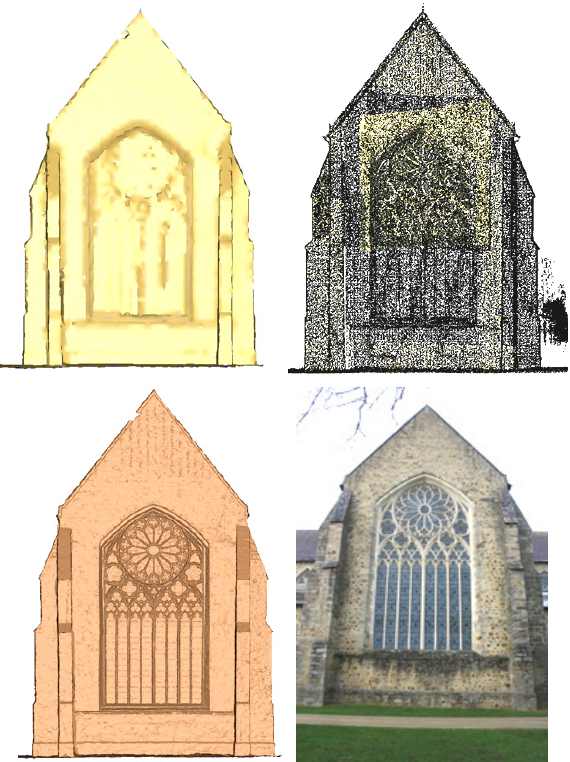
Figure 7. Example of results over a side of the abbey-church. Coarse mesh (at the top left). Superimposition of the debased point cloud and the complete one over the rosette (at the top right). Refined mesh (at the bottom left). Texture image (at the bottom